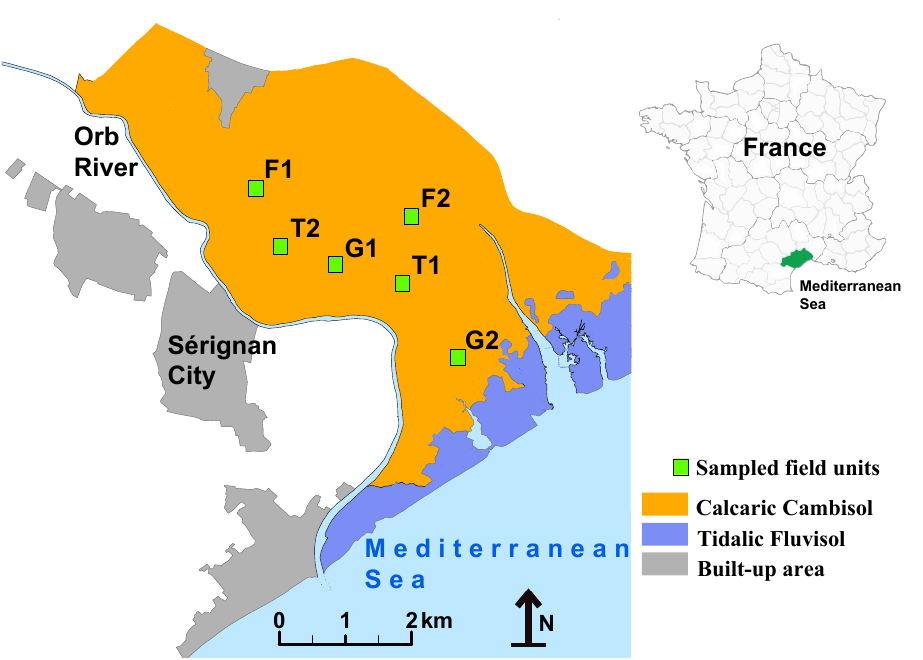
Figure 1. Map of the study area and sampling locations.